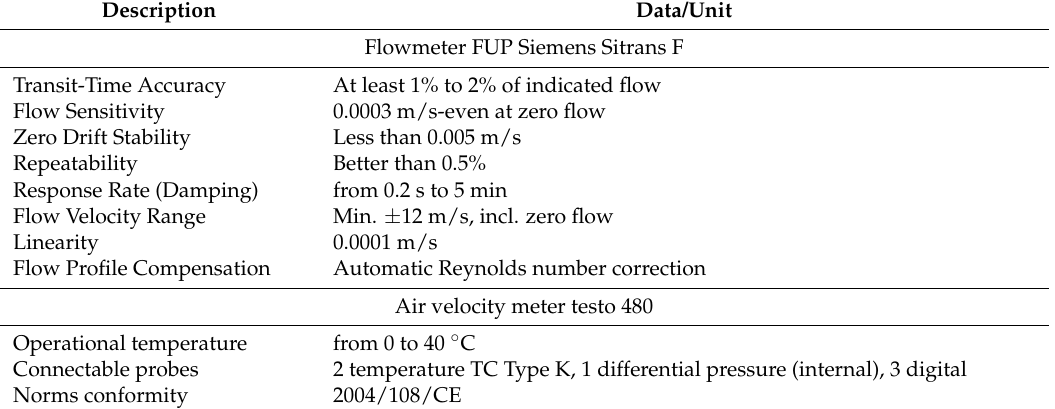
Table 5. Technical specification of the measurement equipment.